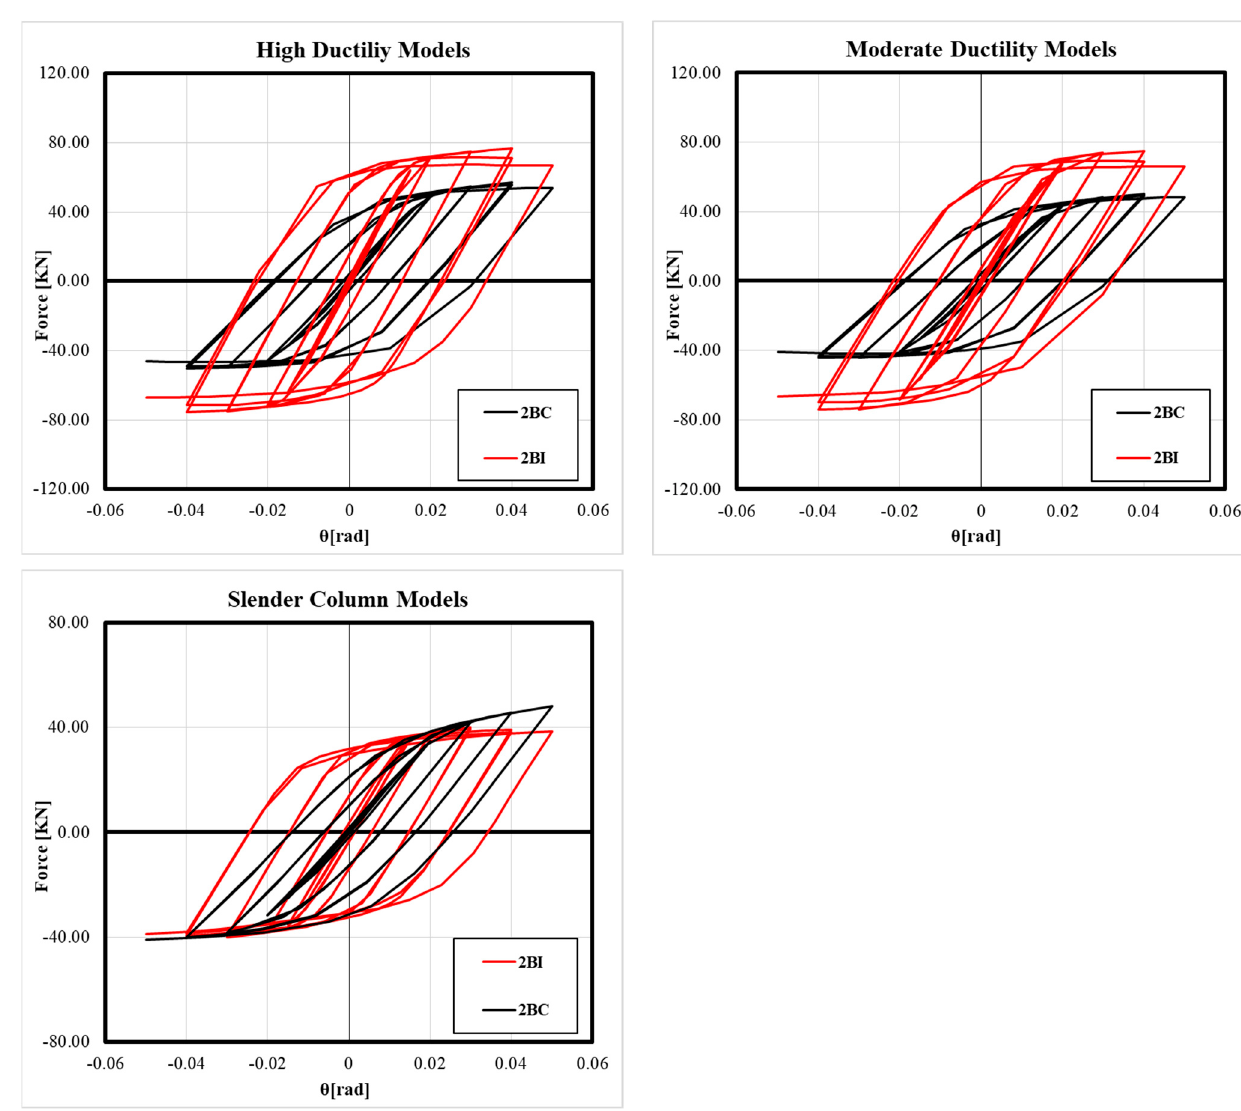
Figure 15. Comparison of the hysteretic curves between joint configurations. Table 5. Summary of the parameters obtained in numerical models.